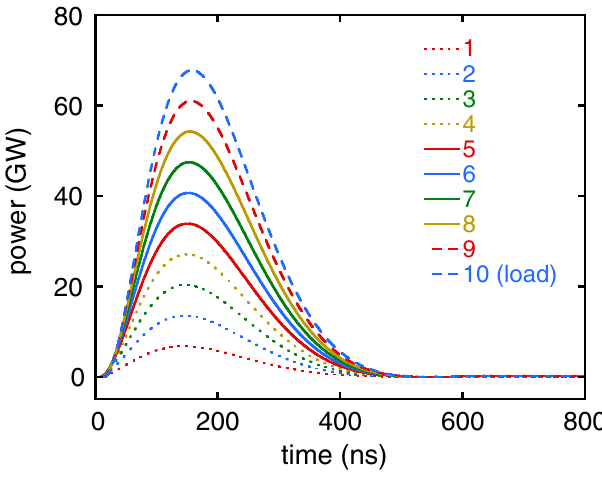
FIG. 13. Simulated electrical-power time histories at the out- puts of the ten transmission-line segments of the ten-stage IMG illustrated by Fig. 11, as given by the circuit model of Fig. 5(a). Since 10 Z ¼ Z , the power at the output of the tenth stage is load identical to that at the